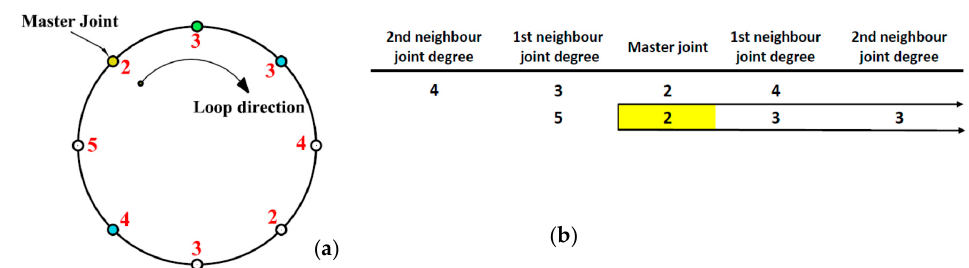
Figure 5. Generation of the ULA. ( a ) loop with two master joints with similar 1st-neighbor joint degrees. ( b ) Comparison between master joint neighbors.